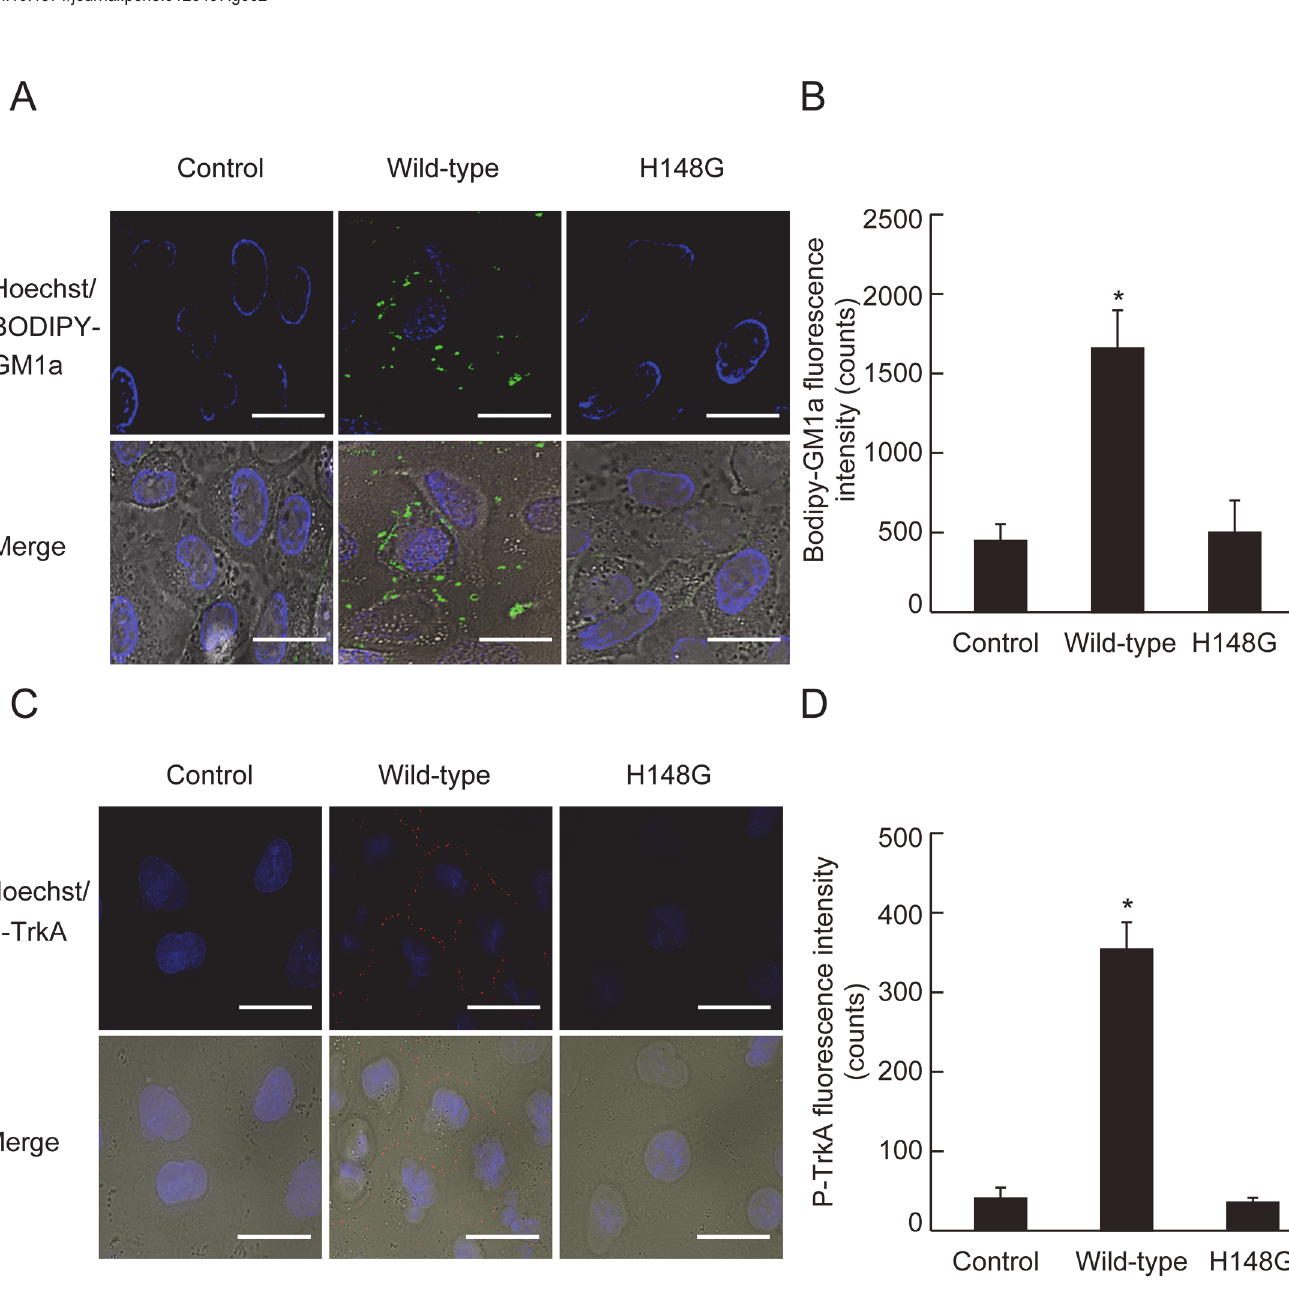
Fig 2. Alpha-toxin induced flip-flop motion in A549 cells. A549 cells were treated with 1.0 μ g/mL wild-type alpha-toxin (A) or H148G alpha-toxin (B) in the presence of Alexa Fluor 488-conjugated annexin V. Fluorescence and differential interference contrast images were acquired at 0, 10, 20, and 30 min after the addition of alpha-toxin. Scale bar, 10 μ m.